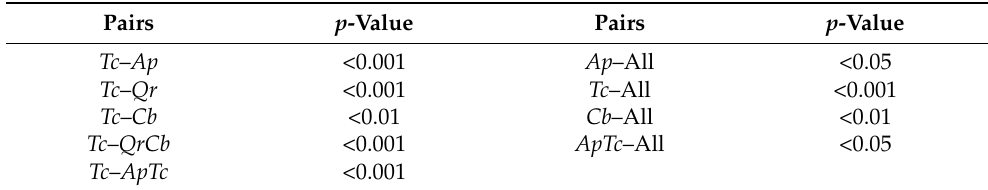
Table 1. Corresponding ANOVA results for the plot-wise LAI results shown in Figure 2 (one- way ANOVA).